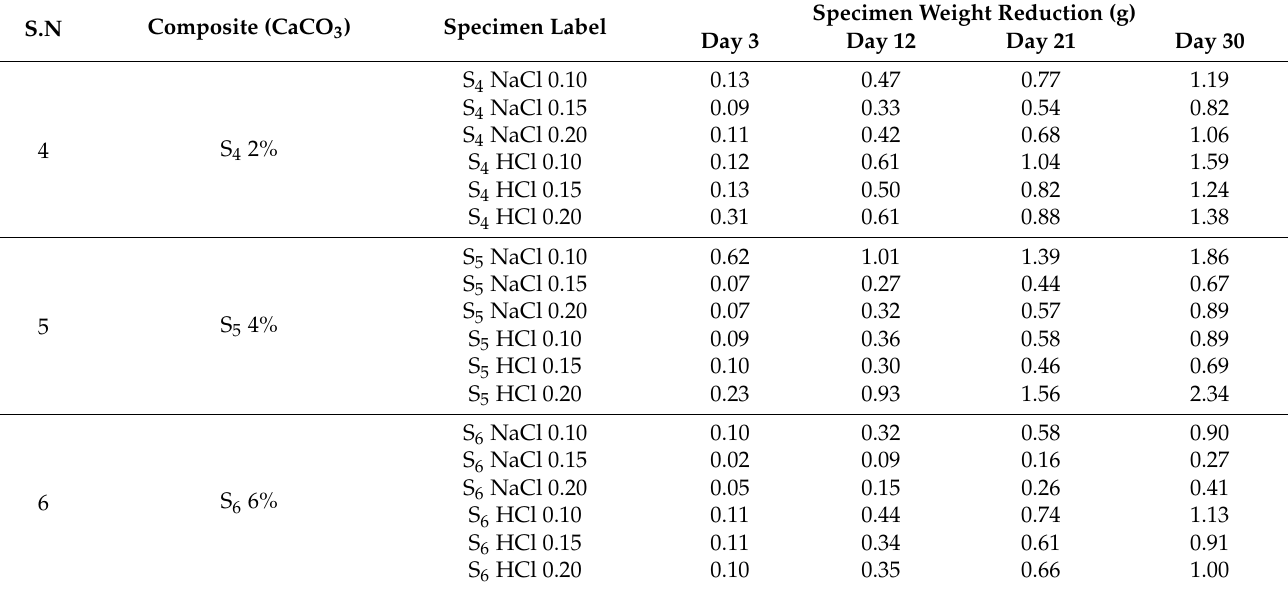
Figure 3. Effect of AgNp + CaCO 3 on corrosion behaviour of S 3 (6%). Table 8. Specimen S 4, S 5 and S 6 weight reduction in HCl and NaCl.